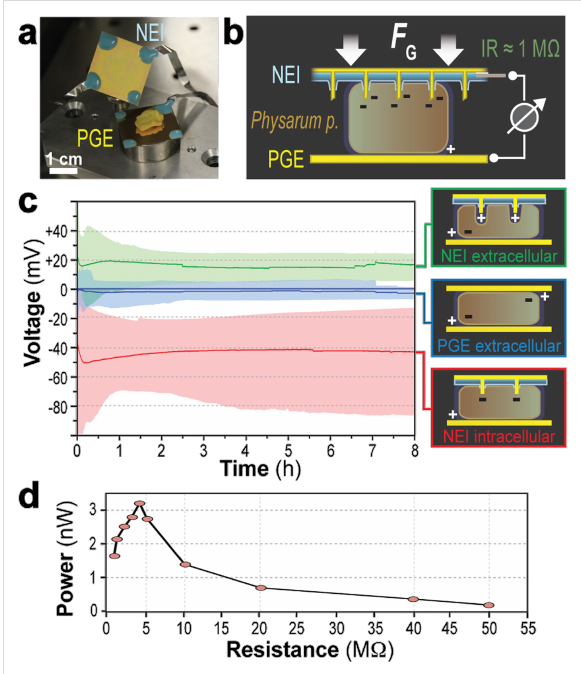
Figure 2: “Symbionic” slime mold/NEI unions. A fragment of Physarum p. was placed between a PGE and an NEI (a) and a weight of 5 g was placed on top ( F G ) to promote uniform electrode penetration (b). The resulting voltage was monitored for at least 8 h with an oscilloscope- based setup with an input resistance of 1 M Ω (c). Traces show the av- erage (line) and range (shaded area) of recordings from Physarum p. sandwiched between either two PGEs or a PGE and an NEI. PGE recordings (blue) represent the extracellular potential (on average zero). NEI/PGE recordings showed either slightly positive voltages (green), presumably reflecting the extracellular potential with a NEI/ PGE local extracellular potential, or negative voltages (red), presum- ably reflecting intracellular, nanoelectrode localization with a − 40 mV membrane potential. For each condition, the mean of n = 10 indepen- dent experiments is shown. Maximal electric output of the intracellu- larly connected Physarum /NEI/PGE configuration was determined by measurements using defined resistors